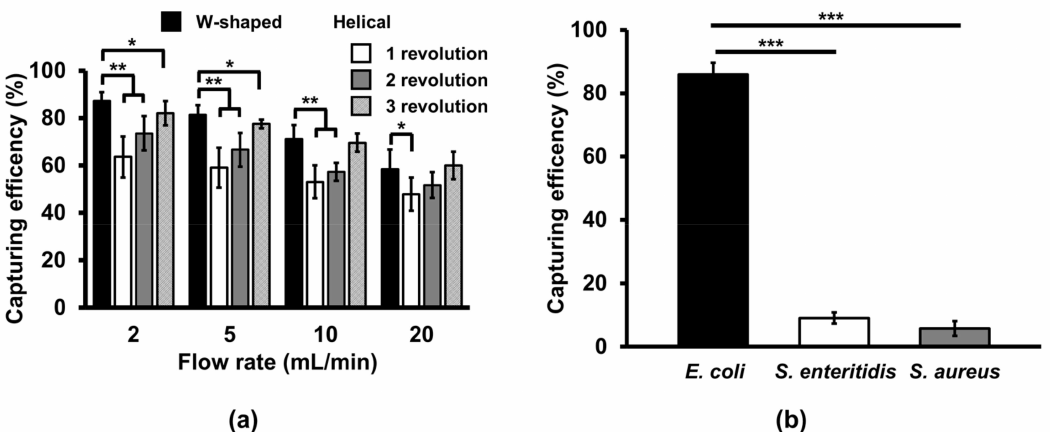
Figure 4. ( a ) Comparison of bacteria capturing e ffi ciency in the W-shaped and helical microchannels at di ff erent revolutions and flow rates. ( b ) Cross-reactivity of Ab-MNPs with either S. aureus or S. enteritidis at 10 5 CFU / mL in 2.5 mL of blood at the flow rate of 5 mL / min in the W-shaped microchannels. Student’s t -test, ***: P < 0.001. **: P < 0.01.*: P < 0.05. n =